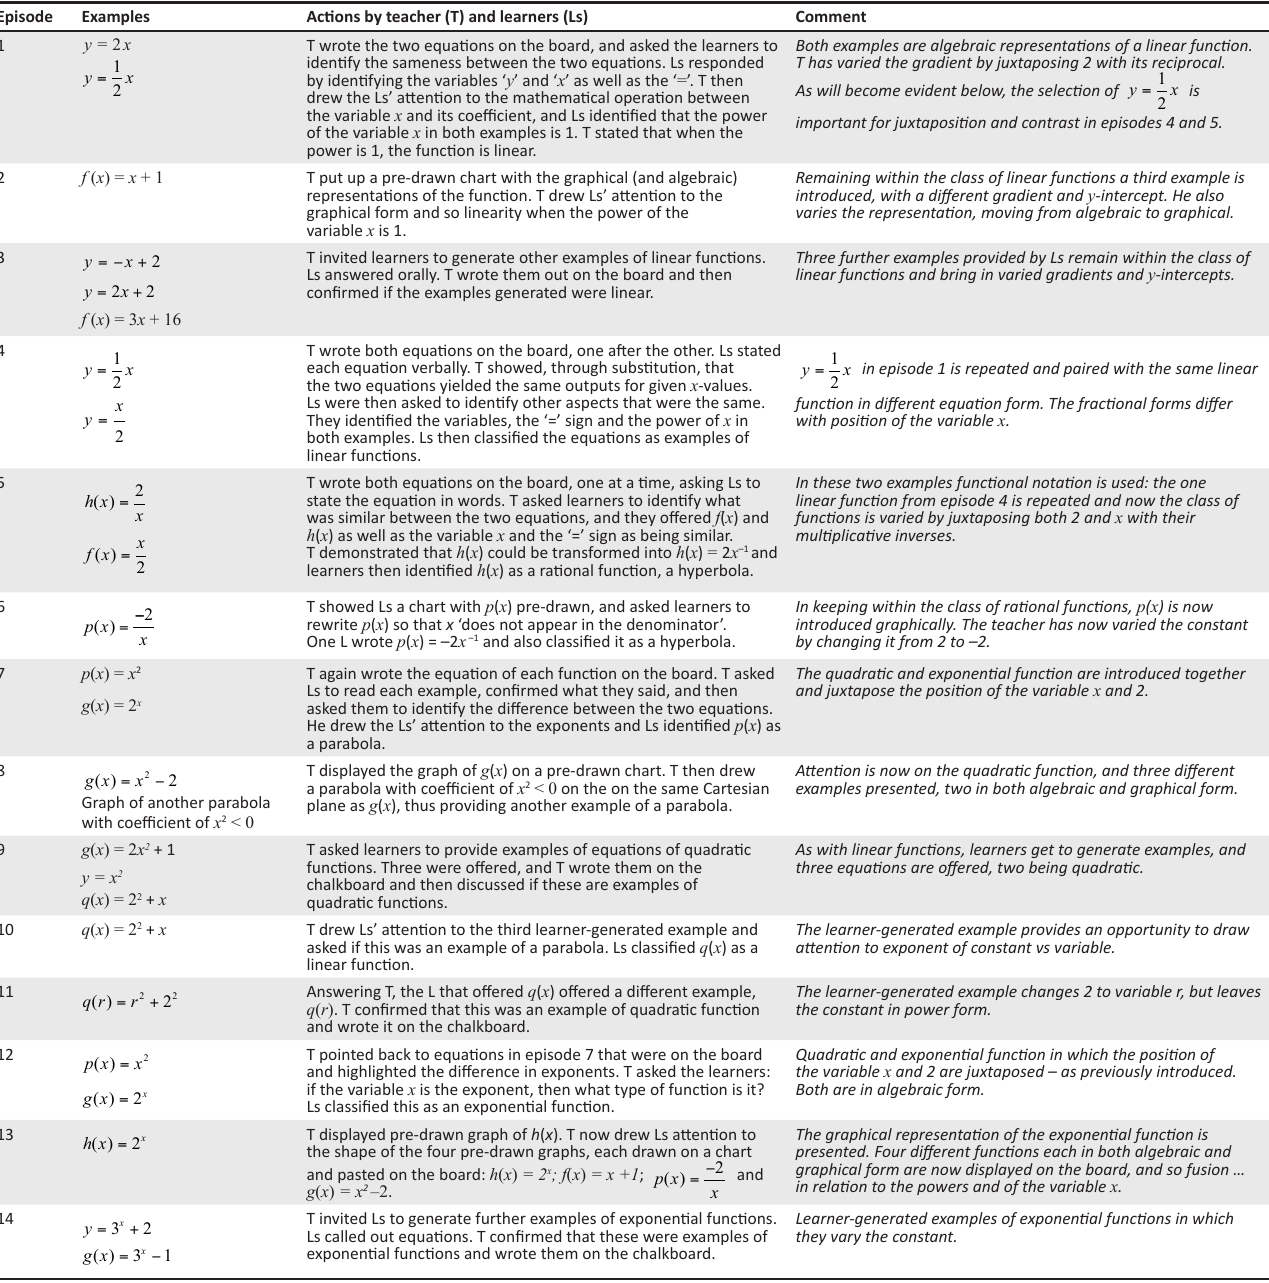
TABLE 1: Overview of the lesson presented in